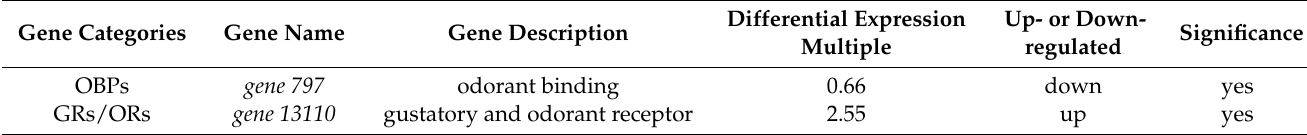
Table 2. Differential expression analysis of chemosensory system genes in BPHs.